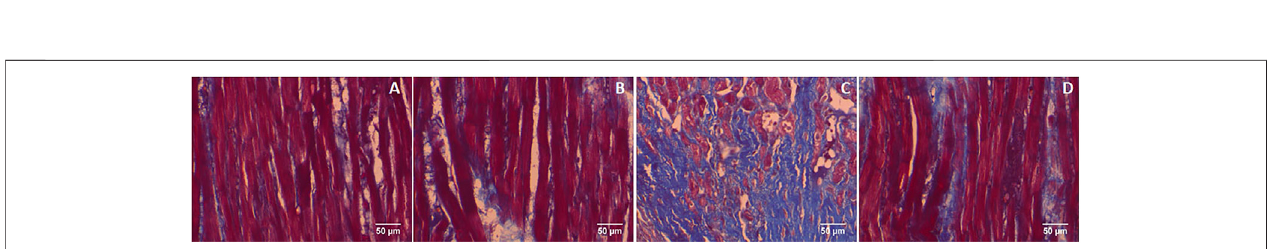
FIGURE 7 | Histopathology of heart tissue stained with H & E staining (40 × ). (A) Control rat shows normal cardiac fi bers (B) . GA alone treated rats show normal cardiac fi bers. (C) ISO-induced rat shows degeneration of myocardial fi bers, edema, and cellular in fi ltration. (D) Pretreatment with GA showed the decreased degenerated myocardial fi bers and cellular in fi ltrations. (E) Treatment with ATV showed normal architecture of cardiac fi bers. (F) Effect of GA on quanti fi cation of in fl ammatory cells in control and ISO-induced rats by Image J software.